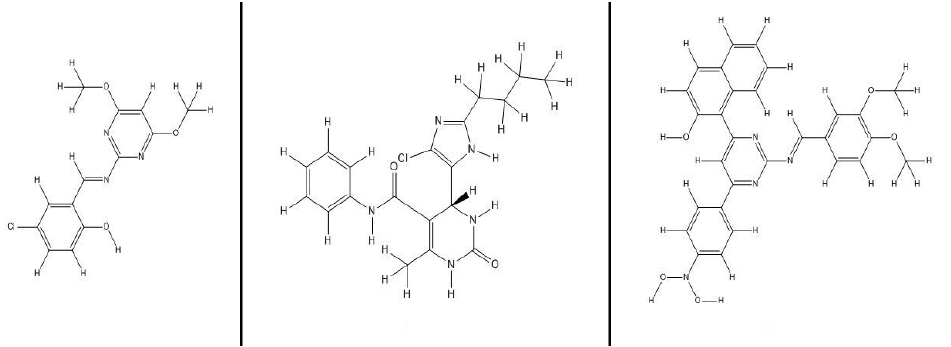
Figure 1. Drug molecules have a pyrimidine ring in their molecular structure.